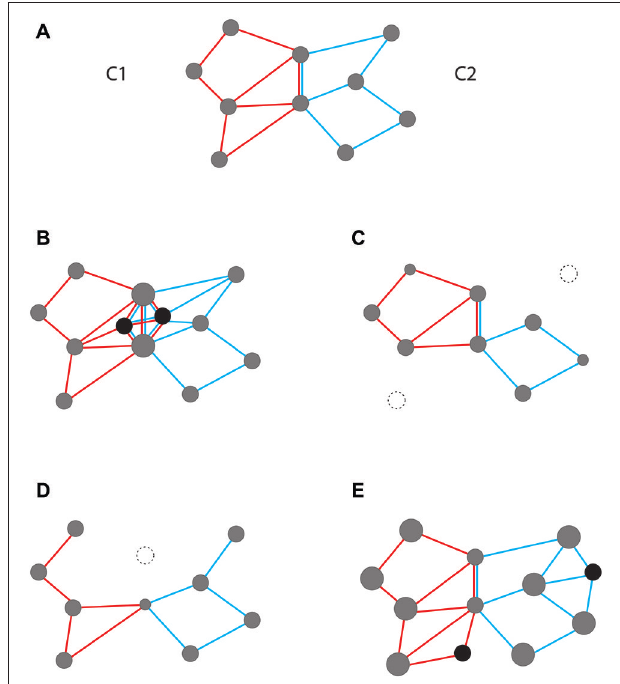
FIGURE 2 | Two overlapping event codes, instantiated as intersecting feature compounds (C1 and C2 with red and blue edges, respectively) . Overlap is indicated by feature nodes on which red and blue edges converge (= shared features). (A) Initial scheme with equal feature weights. (B–E) Possible structural changes under conditions of code cooperation (B,C) and code competition (D,E) . (B) Strengthening shared features through (i) increasing weights of old features (node size); and (ii) including new features that are shared (black); (C) Weakening unshared features through weight reduction and deletion (dotted); (D) Weakening shared features through weight reduction and deletion; (E) Strengthening unshared features through weight increase and inclusion of novel